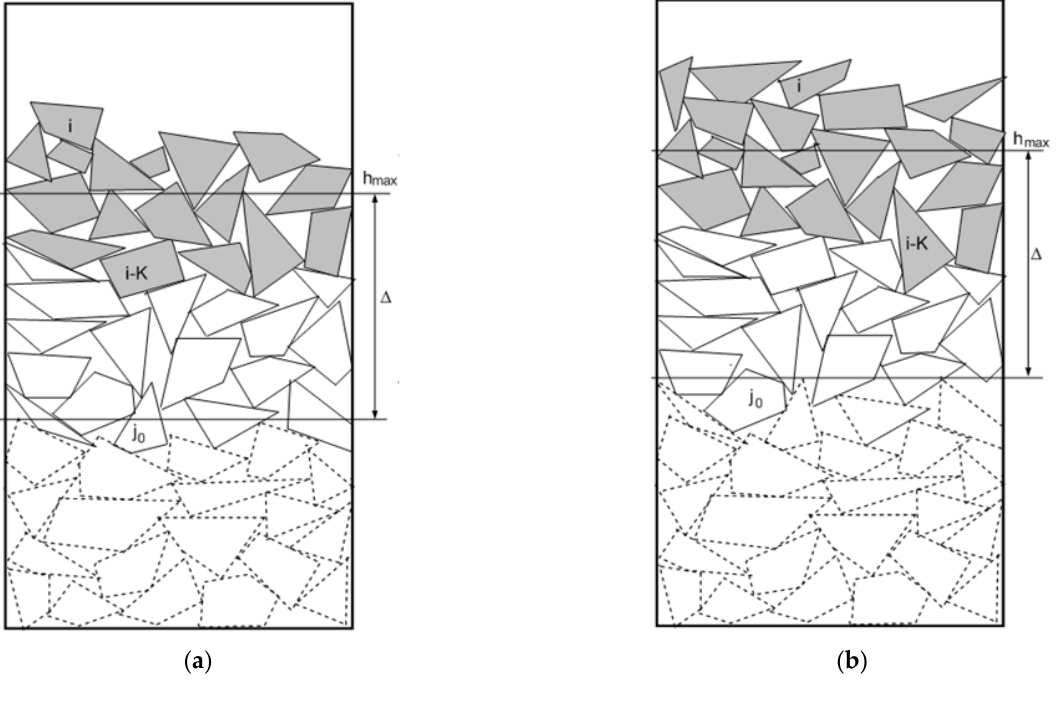
Figure 1. Illustrations to step 7: ( a ) m a x ii z h R =+−  ; ( b ) recalculation of ℎ 𝑚𝑎𝑥 and Δ of the active Figure 2. Illustrations to step 7: ( a ) z i = h max + R i − ∆ ; ( b ) recalculation of h max and ∆ of the active layer.